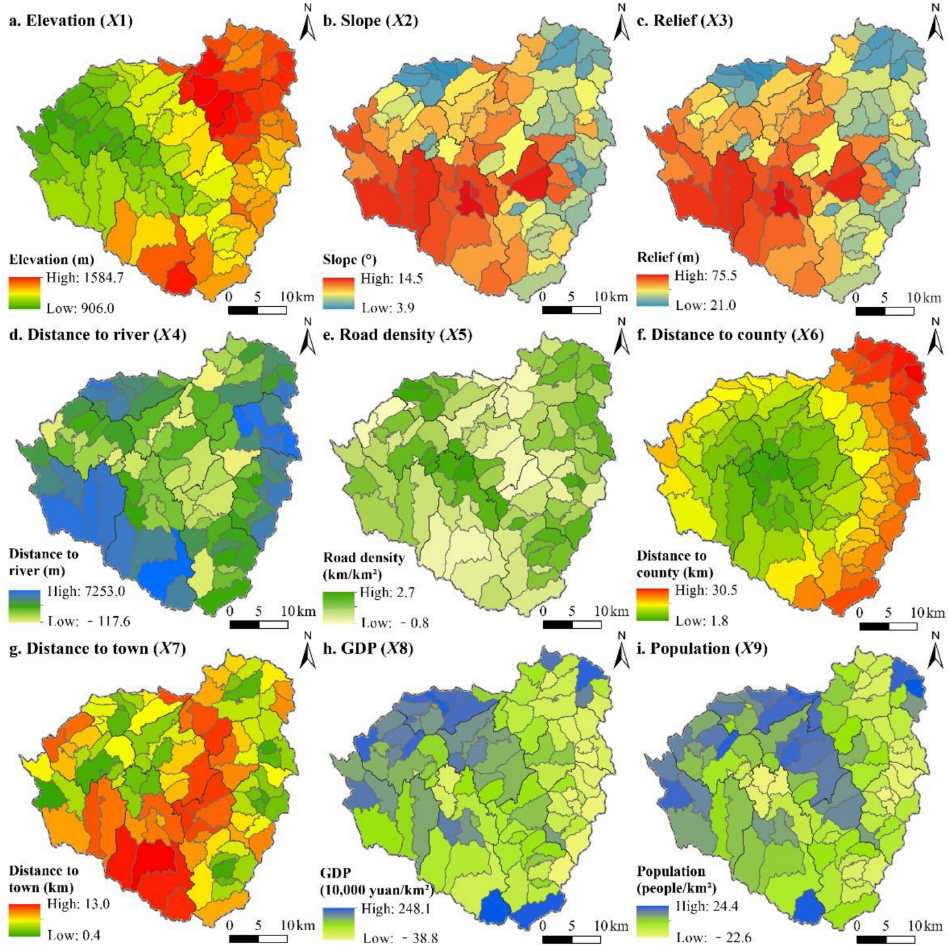
Figure 7. Spatial distribution of main factors driving land use transition in Pu